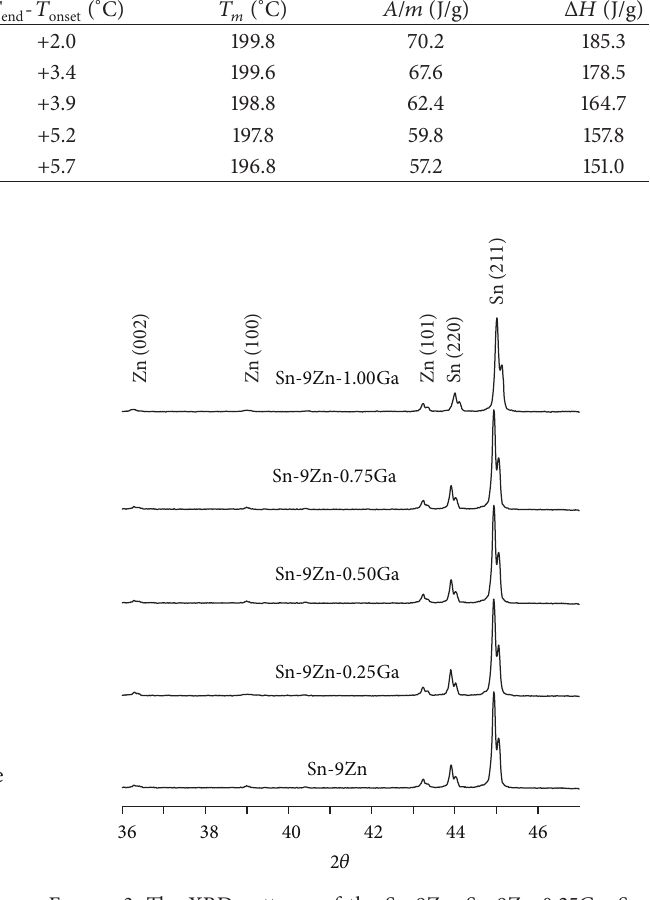
Figure 3: The XRD patterns of the Sn-9Zn, Sn-9Zn-0.25Ga, Sn- 9Zn-0.50Ga, Sn-9Zn-0.75Ga, and Sn-9Zn-1.00Ga solder